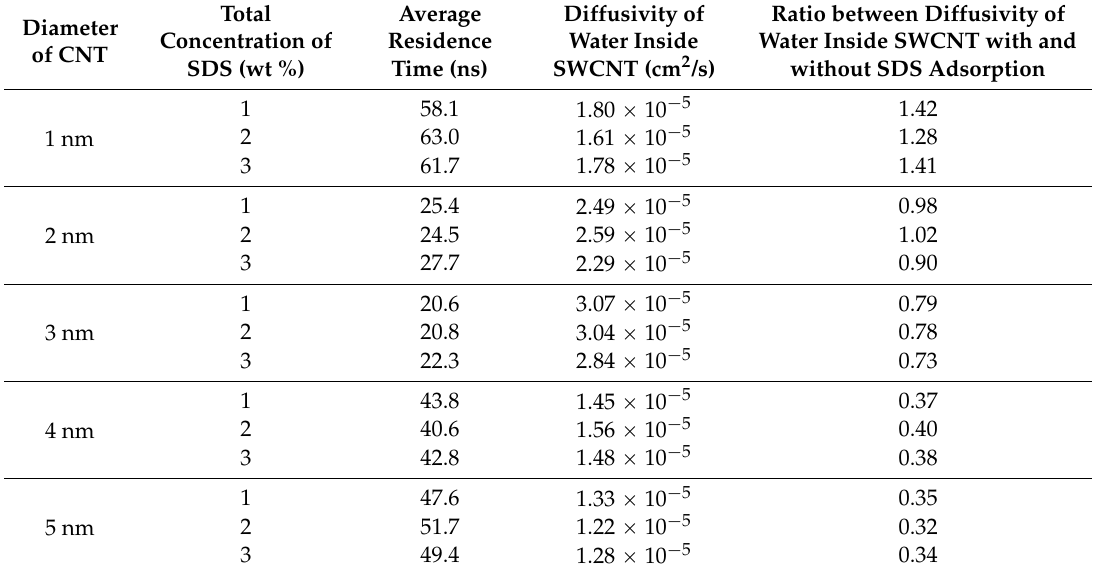
Table 3. Diffusivity and residence time of water in the effect of SDS